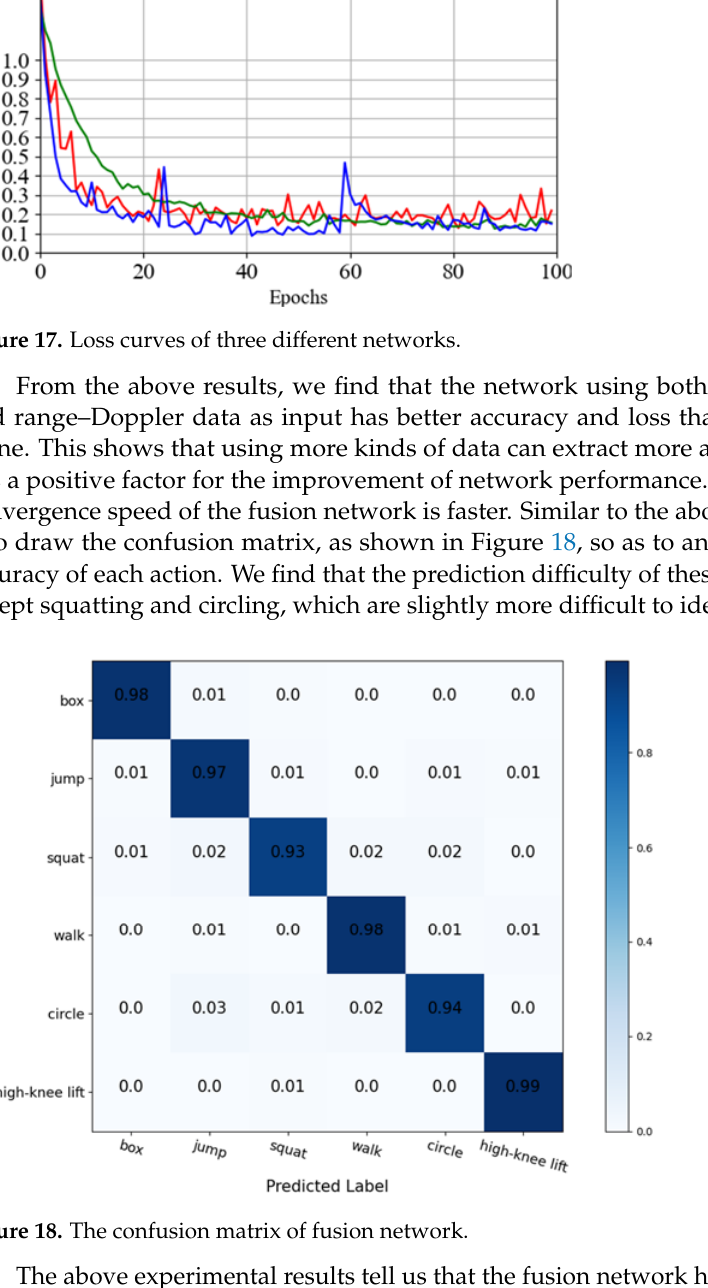
Figure 17. Loss curves of three different networks. Table 4. Accuracy and Loss of The Three Networks Using Different Kinds of Input.